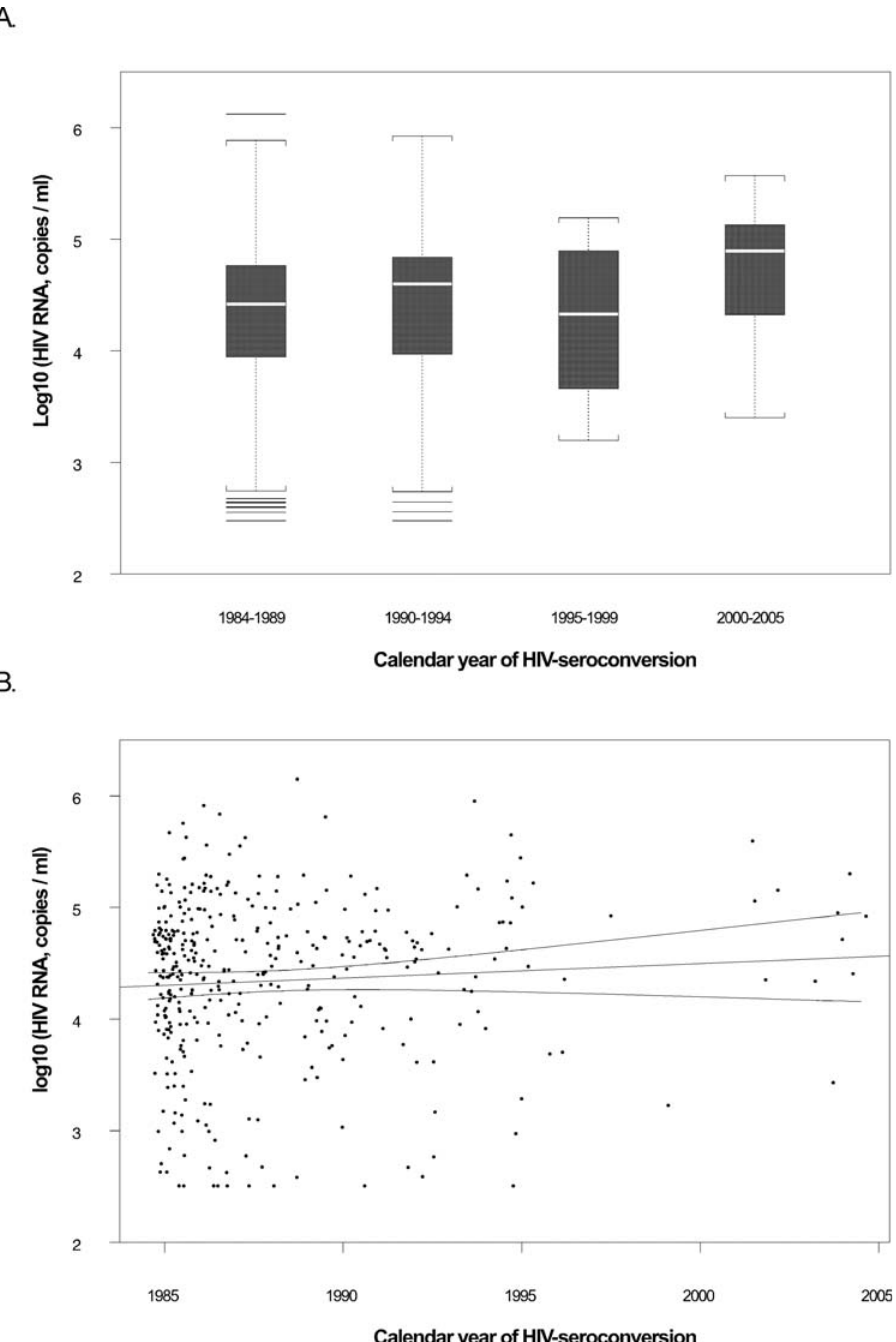
Figure 1. RNA viral loads through time. A) Boxplot for the mean of log10 HIV RNA at second and third seropositive visits ( , 9 and , 15 months after estimated date of seroconversion) by calendar period of seroconversion. The horizontal line in the interior of the box denotes the median; and the height of the box is equal to the interquartile distance (IQD). The whiskers (the dotted lines extending from the top and bottom of the box) extend to the extreme values of the data or a distance 1.5 6 IQD from the center, whichever is less. The horizontal lines falling outside the whiskers represent outliers. B) Relationship between the mean of log10 HIV RNA at second and third seropositive visits and calendar year of seroconversion. Three solid lines are the fitted regression line and its 95% confidence bands from univariate linear regression (note that slope estimates reported in manuscript text are from multivariate analysis).